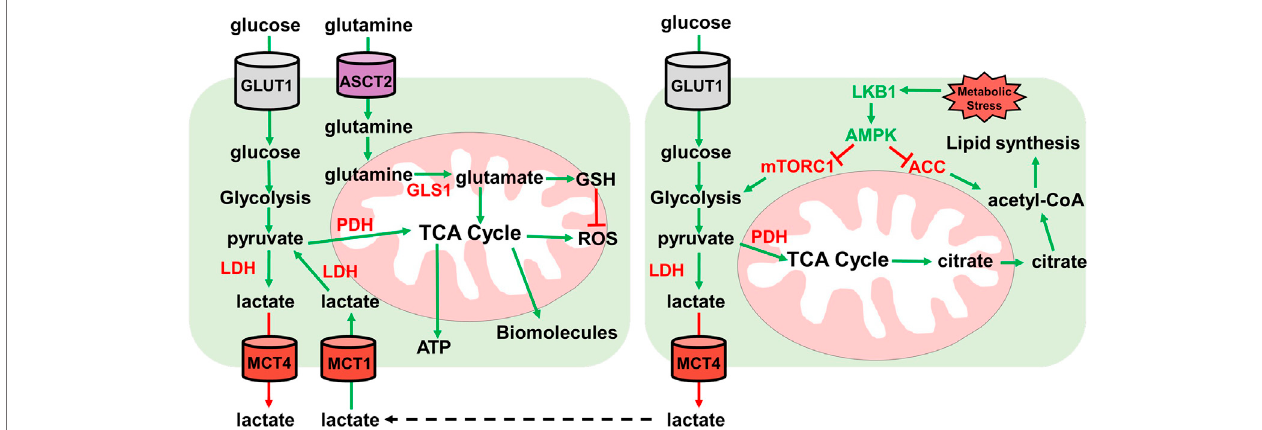
FIGURE 3 | Lactate and glutamine metabolism. Overview of lactate and glutamine metabolism. Glucose is imported by GLUT1 transporter. Glucose is then metabolized by glycolysis into pyruvate. Pyruvate then either enters the TCA cycle through pyruvate dehydrogenase (PDH) for ATP and biomolecule synthesis, or pyruvateisconverted tolactatebylactate dehydrogenase (LDH). LactateisthenexportedbyMCT4lactate exporter. Extracellularlactatecanbe imported byMCT1and converted to pyruvate by lactate dehydrogenase for utilization in the TCA cycle for ATP and biomolecule synthesis. Glutamine is imported by ASCT2 where it then enters the mitochondria and is converted to glutamate. Glutamate can either enter the TCA cycle or is converted to GSH for ROS neutralization. Under metabolic stress conditions, the LKB1-AMPK pathway is activated. LKB1 activates AMPK which inhibits ACC and mTORC1. AMPK inhibition of ACC prevents lipid synthesis and mTORC1 inhibition by AMPK reduces glycolysis. Low glycolysis rate reduces TCA cycle generation of citrate which is used to generate acetyl-CoA for lipid synthesis.